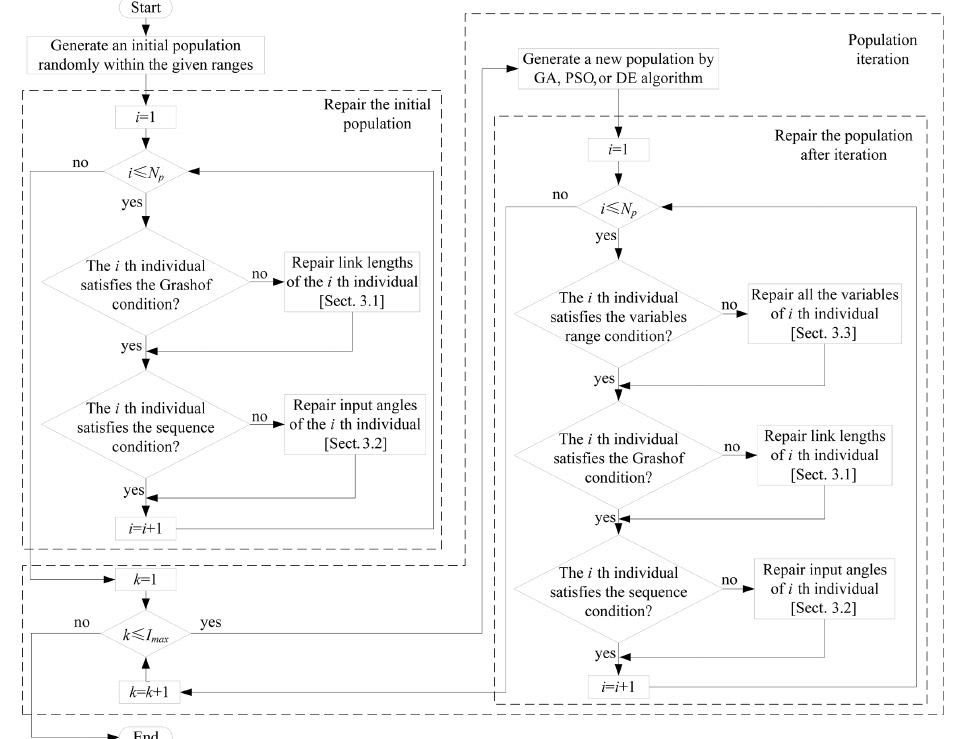
Figure 6. Schematic diagram of the application of the IR method with different optimization algorithms.